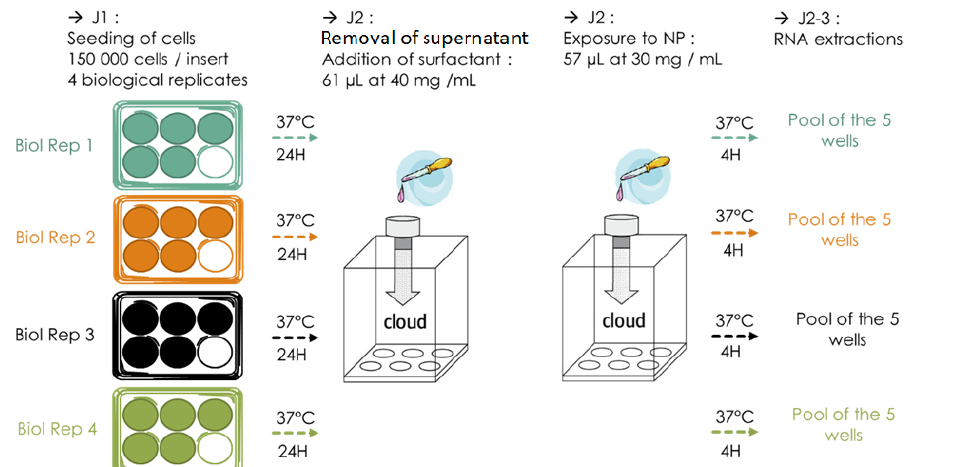
Figure 4. Initial exposure protocol. For each 4 biological replicates (BR), NR8383 were seeded in 5 wells, in Transwell ® inserts. The next day, for each BR, the inserts containing the cells were exposed, by nebulization, back-to-back with 61 µL of whole porcine surfactant at 40 mg/mL, and with 57 µL of TiO 2 NP at 30 mg/mL. After exposures, the Transwell ® inserts containing the cells were kept at 37 °C for 4 h, and the 5 wells (representing technical replicates, TR) of each BR were pooled for RNA extractions.